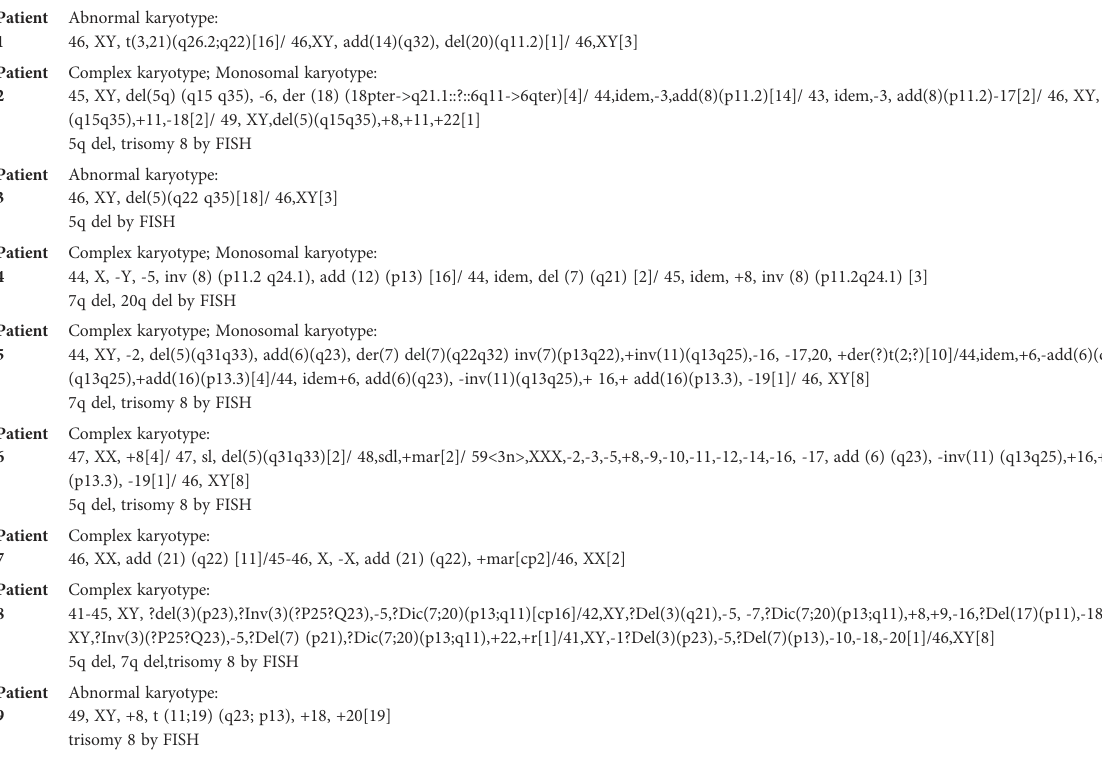
TABLE 4 Cytogenetic characteristics of the nine patients.